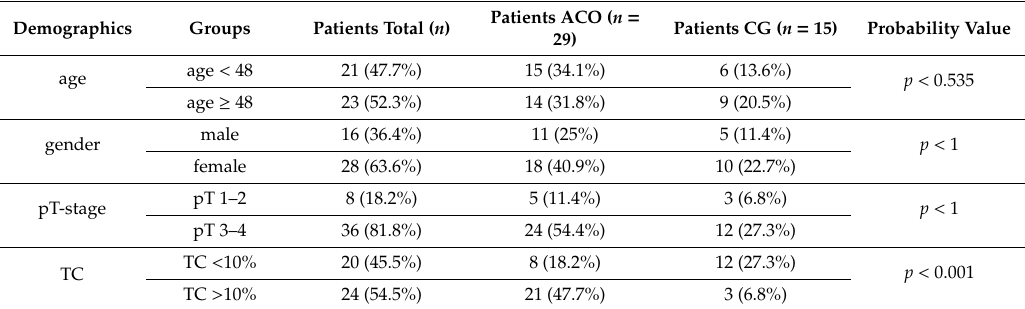
Table 7. Clinicopathologic characteristics of a subset of the study collective which underwent miRNA profiling; adverse outcome (ACO), control group (CG), TC (tall cell), chi-square